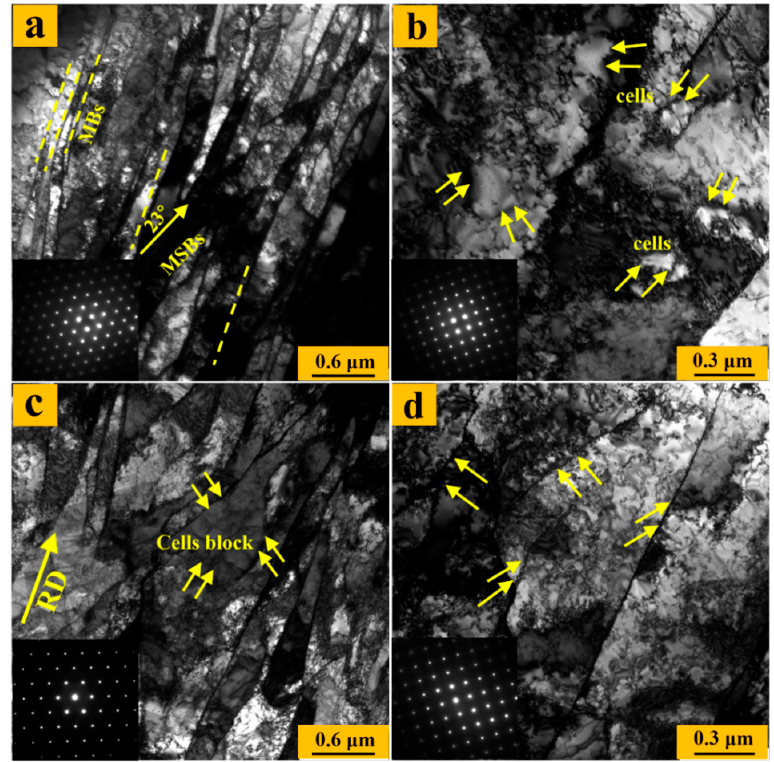
Figure 12. TEM images of the UR and CR samples. UR: ( a ) {111} matrix and ( b ) {100} matrix. CR: ( c ) {111} matrix and ( d ) {100} matrix.